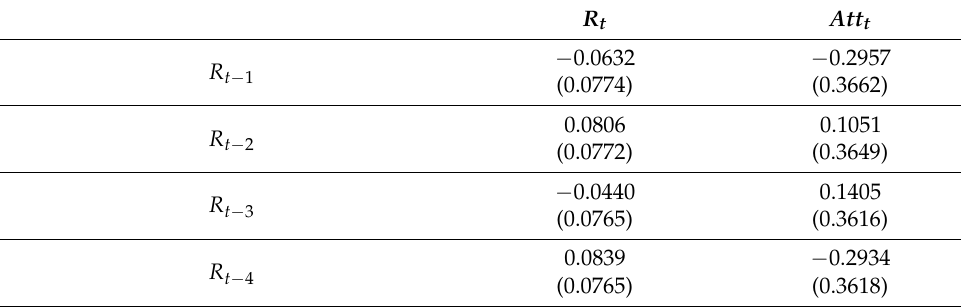
Table 12. Updating the investor attention to Twitter-based